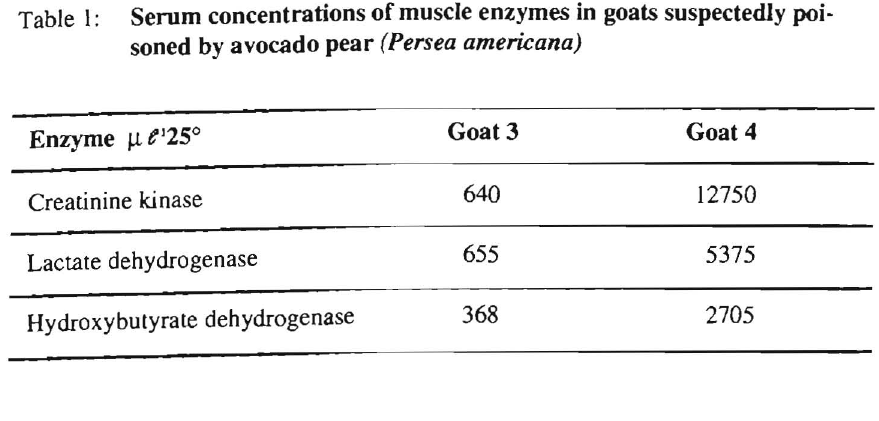
sounds increased and she coughed occa sionally _ Goat 4, which was heavily pregnant, had a temperature of 39,5°C, a heart rate of 180 min-' and a respiratory rate of 60 min-'. The intensity of her respiratory sounds also increased and she tended to lie down. Both had a de creased appetite, but no other abnor malities were found. -Haematological examinations demon strated a leucocytosis due to an increase in both mature and immature neutrophils. The leucocytosis was more pronounced in Goat 4, mainly due. to larger numbers of immature neutrophils. Serum concentrations of muscle enzymes in goats suspectedly poi soned by avocado pear (Persea americana)